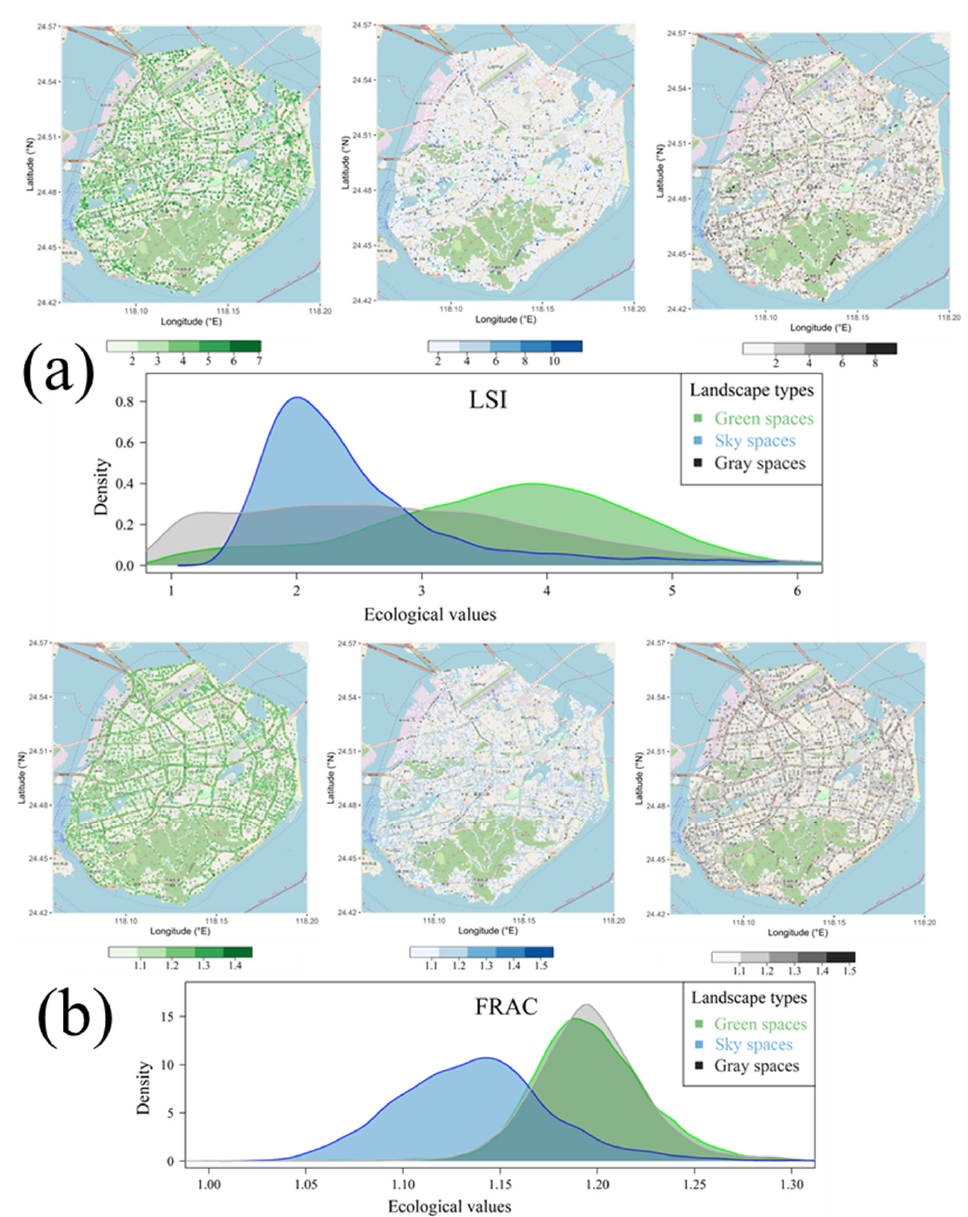
Figure 6. The spatial and density distribution for ecological landscape indicators, ( a ) for LSI and ( b ) for FRAC.